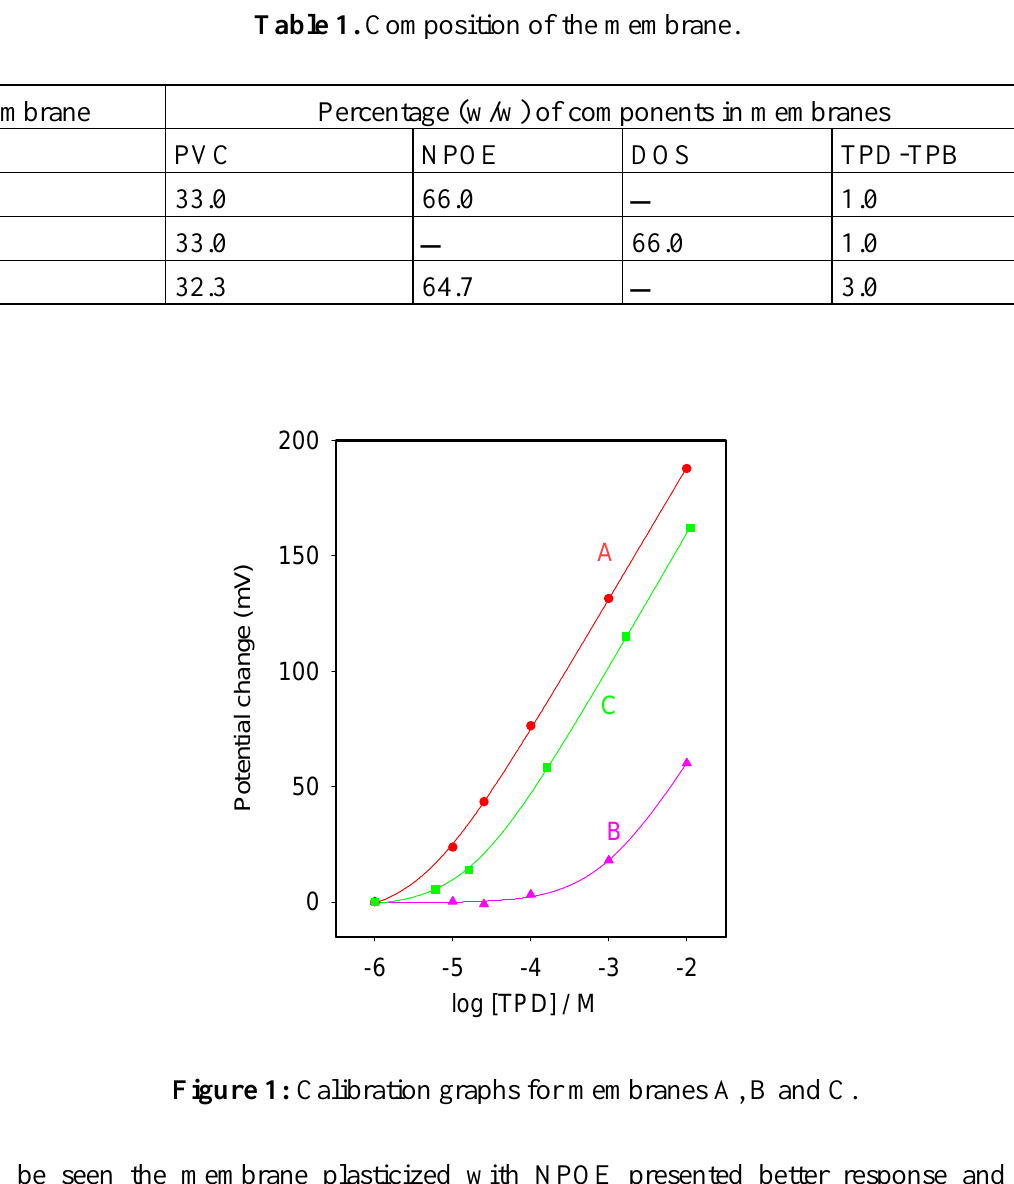
Table 1. Composition of the membrane.